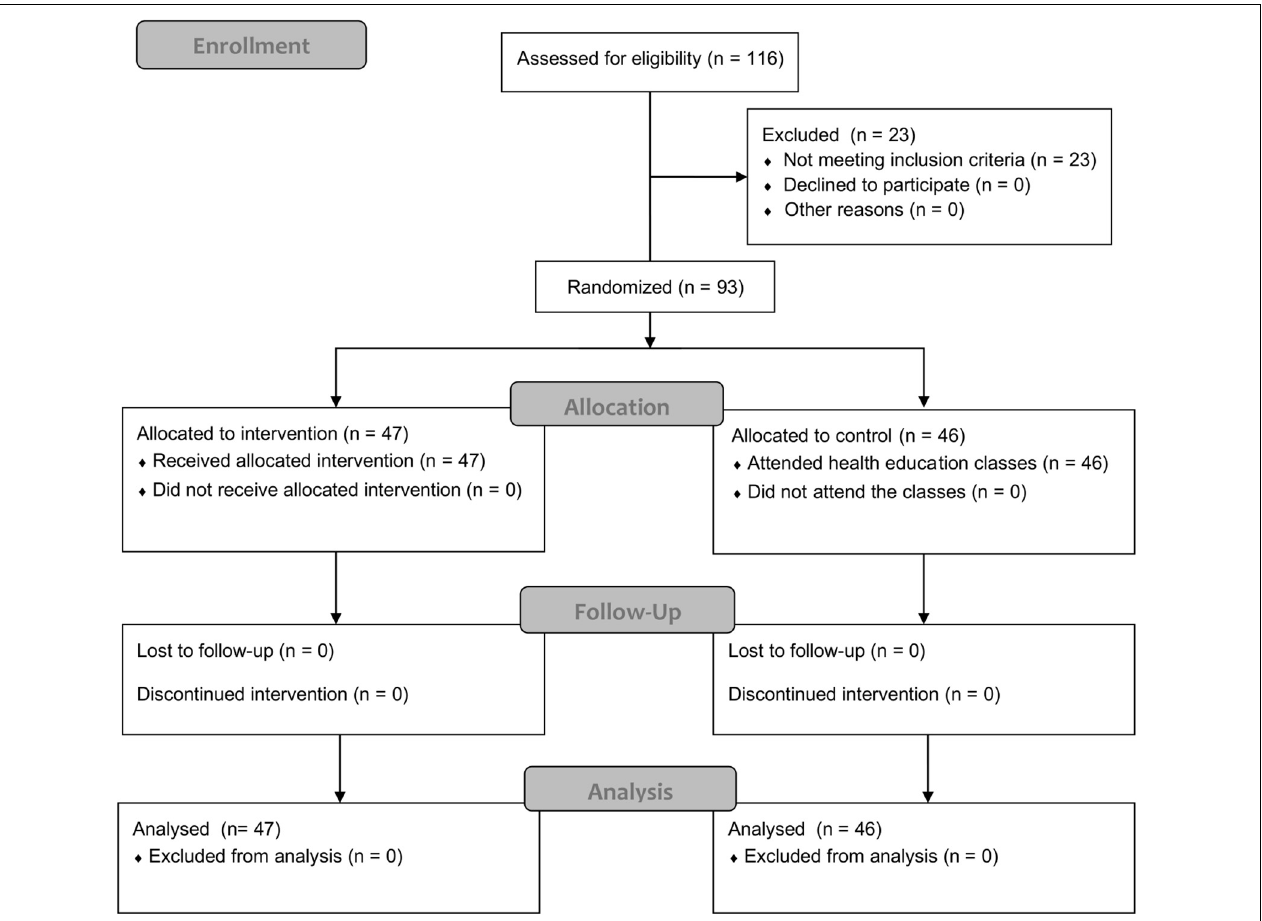
FIGURE 1 | Flow diagram of enrollment, allocation, follow-up, and data